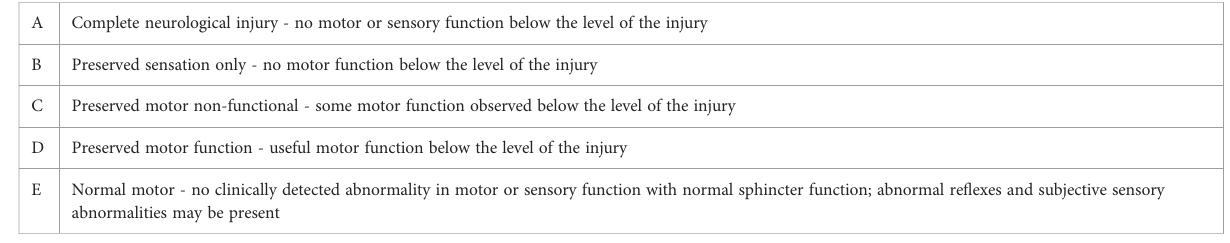
TABLE 4 Frankel scale evaluating functional outcomes in spinal cord